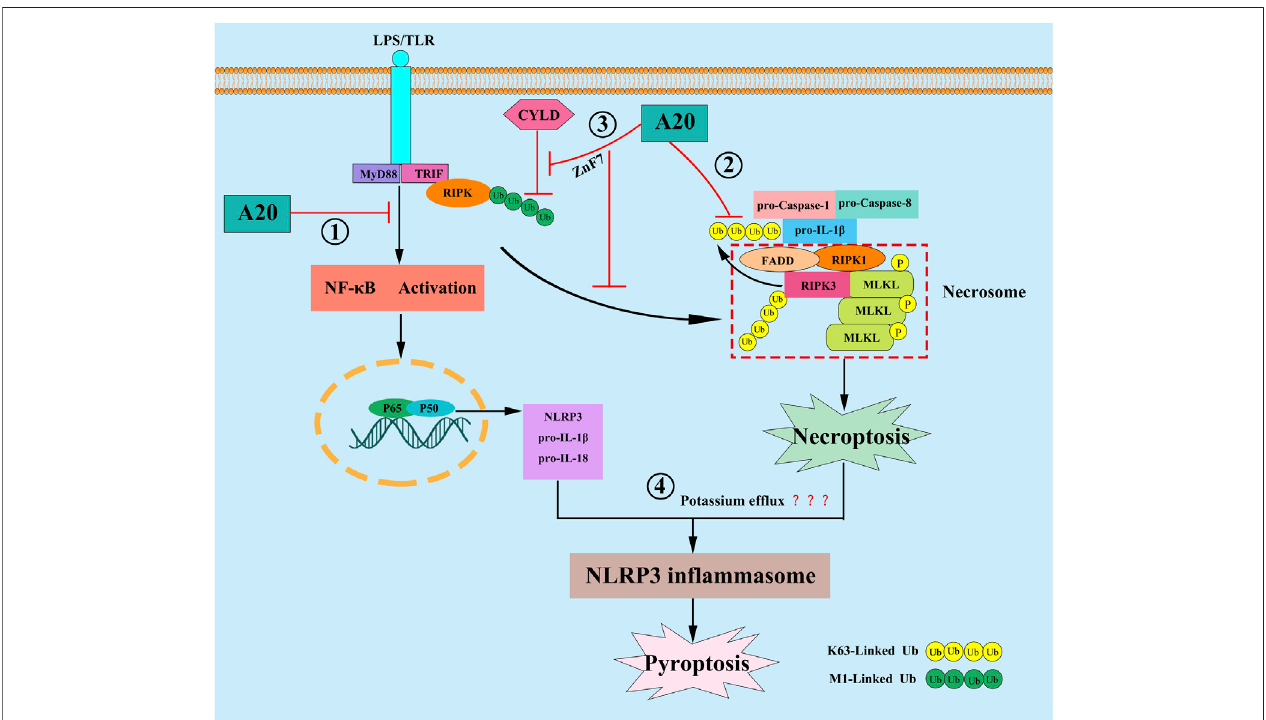
FIGURE 3 | In response to LPS stimulation, A20 is reported to inhibit pyroptosis by the following mechanisms: ① A20 inhibit pyroptosis through inhibiting NF- κ B signaling, resulting in the down-regulation of NLRP3 and pro-IL-1 β ; ② A20 directly interact with the ubiquitylated pro-IL-1 β complex, consisting of pro-Caspase-1, pro- Caspase-8,RIPK1andRIPK3,andtheninhibittheformationofRIPK3-dependentK63-Linkedpolyubiquitinchainsofpro-IL-1 β ,andfurtherrepressingtheconversionof pro-IL-1 β to mature IL-1 β ; ③ A20 stabilize M1-Linked polyubiquitin chains of RIPK1 by preventing its CYLD-mediated degradation through its ZnF7 domain, then preventing NLRP3 in fl ammasome activation by inhibiting RIPK1-dependent, RIPK3-MLKL-mediated macrophage necroptosis; ④ A20 may limit necroptosis-induced NLRP3 in fl ammasome activation by suppressing the potassium ef fl ux.